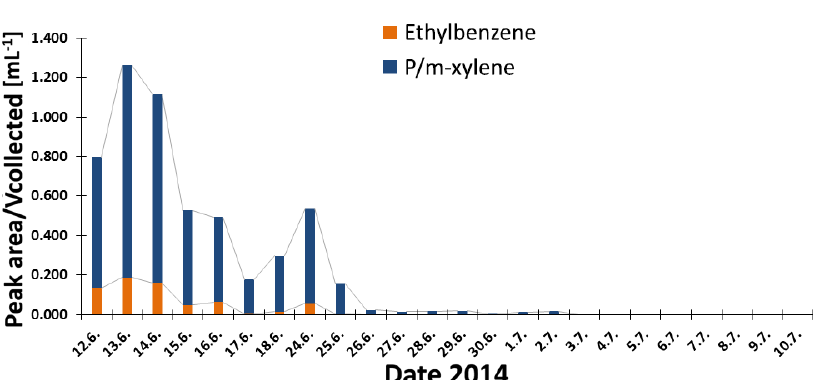
Figure 3. Occurrence of pollution events during the summer campaign, 2014. Ethylbenzene and p/m -xylene were identified and monitored by NTME and portable GC–MS during the campaign period.